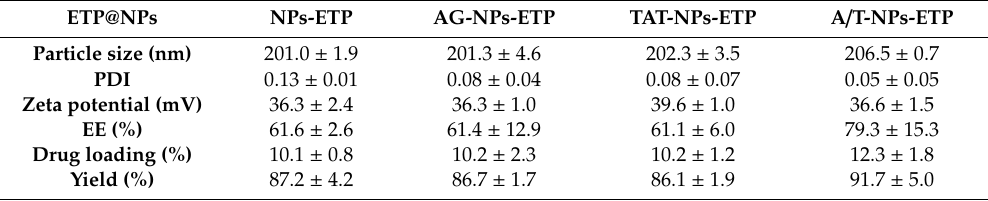
Table 2. Characteristics of ETP@NPs ( n = 3).